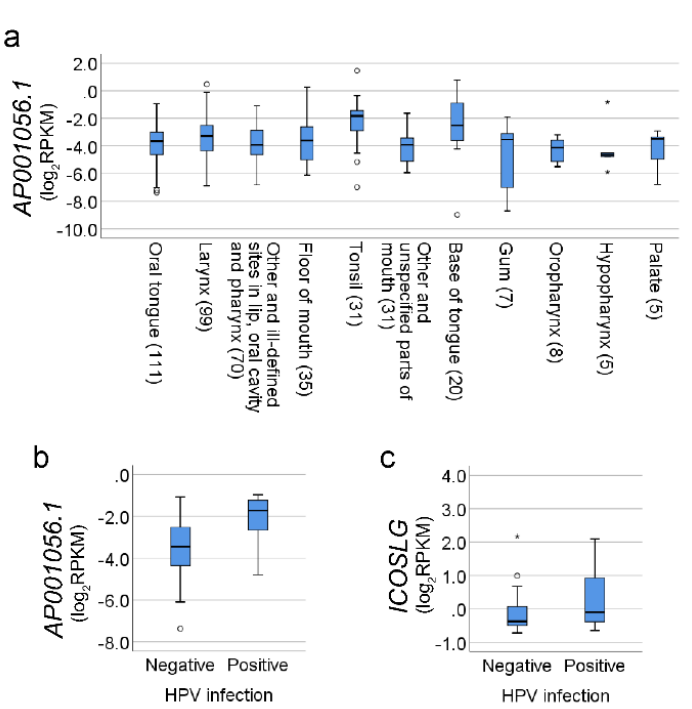
Figure 2. Gene expression related to tumor subsite and human papillomavirus (HPV) status. ( a ) Boxplots showing levels of AP001056.1 in different tumor subsites. Values in brackets show number of patients. ( b , c ) Boxplots showing levels of AP001056.1 and ICOSLG in HPV-positive and HPV-negative SCCHN tumors. Small circles indicate outliers and asterisks, (*) extreme outliers. Table 3. List of immune genes associated with AP001056.1 expression ( r ≥ 0.600, p < 0.001).